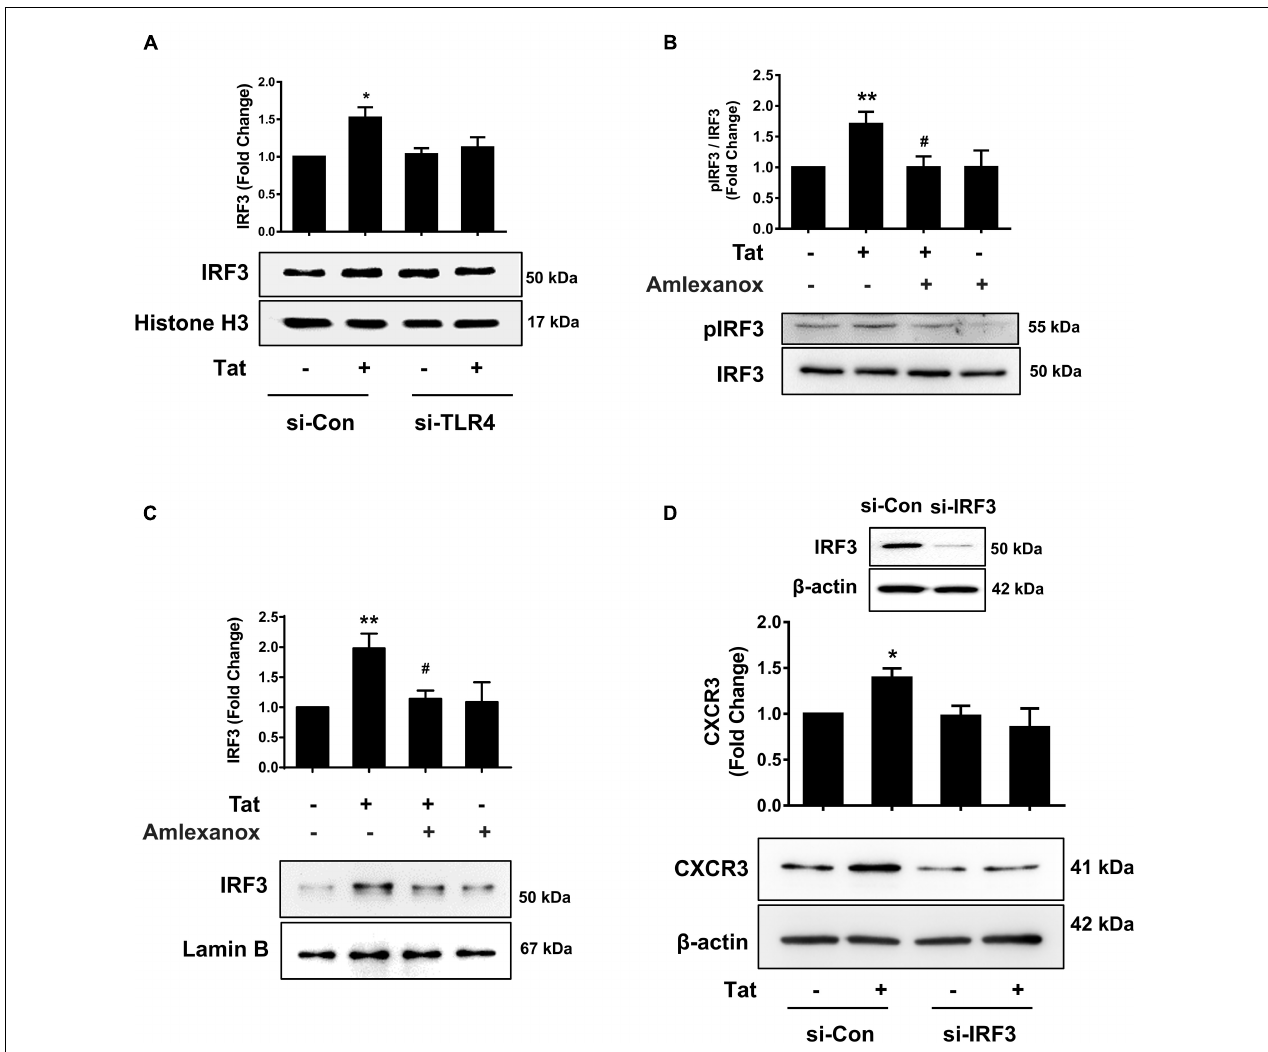
FIGURE 6 | Involvement of IRF3 in HIV Tat-mediated upregulation of CXCR3 expression. (A) Representative Western blot and quantification of IRF3 in the nuclear cell lysates of human monocytes transfected with TLR4 siRNA and si-Con followed by HIV Tat exposure. N = 3. (B) Representative Western blot and quantification of p-IRF3, IRF3 in the cell lysates from human monocytes pretreated with TBK1 inhibitor Amlexanox (2 µ M), followed by HIV Tat exposure for 15 min. N = 5. (C) Representative Western blot and quantification of IRF3 in the nuclear cell lysates of human monocytes pretreated with TBK1 inhibitor Amlexanox (2 µ M), followed by HIV Tat exposure for 15 min. N = 3. (D) Representative Western blot of silencing of IRF3 in human monocytes transfected with IRF3 siRNA (si-IRF3). Representative Western blot and quantification of CXCR3 in the cell lysates from human monocytes transfected with IRF3 siRNA and nonsense siRNA transfected controls (si-Con) followed by HIV Tat exposure. N = 3. One-way ANOVA with post hoc test. All data are presented as mean ± SD of three or four individual experiments (Biological replicates). * p < 0.05 versus control group; ** p < 0.01 versus control group; # p < 0.05 versus HIV Tat